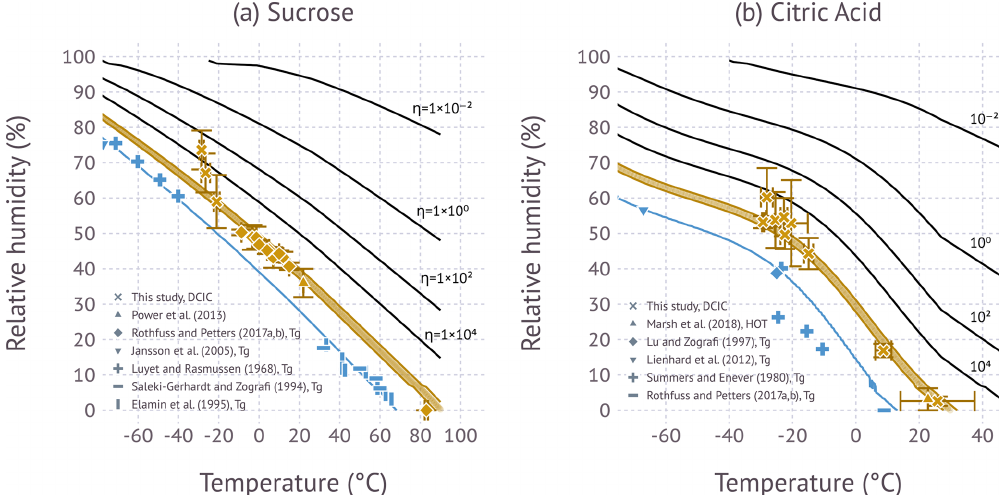
Figure 4. The symbols show glass transition (blue) and viscosity data (gold) as a function of temperature and RH. Viscosity data from Power et al. (Power et al., 2013; sucrose) and Marsh et al. (Marsh et al., 2018; citric acid) are from holographic optical tweezer (HOT) measurement. Viscosity data from Rothfuss and Petters (2017a) and this study are from the DCIC method. Data lines correspond to contours computed from the computed η(T, RH ) field evaluated for 10 12 Pas (blue), 5 × 10 6 to 4 . 8 × 10 7 Pas for sucrose (gold-shaded area) and 5 × 10 6 to 3 . 8 × 10 7 Pas for citric acid (gold-shaded area), and 10 4 to 10 − 2 Pas